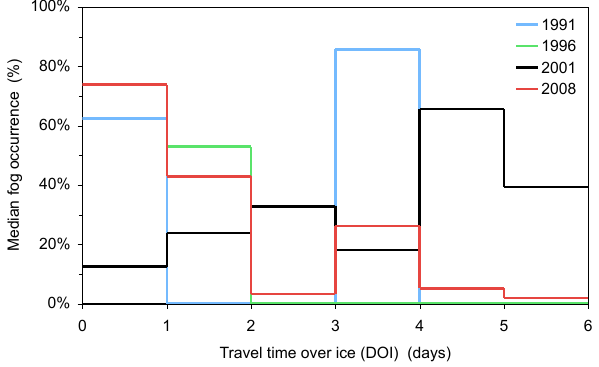
Fig. 4. Median values of fog occurrence per hour in % as a function of travel time over ice (DOI, days) for the four Oden